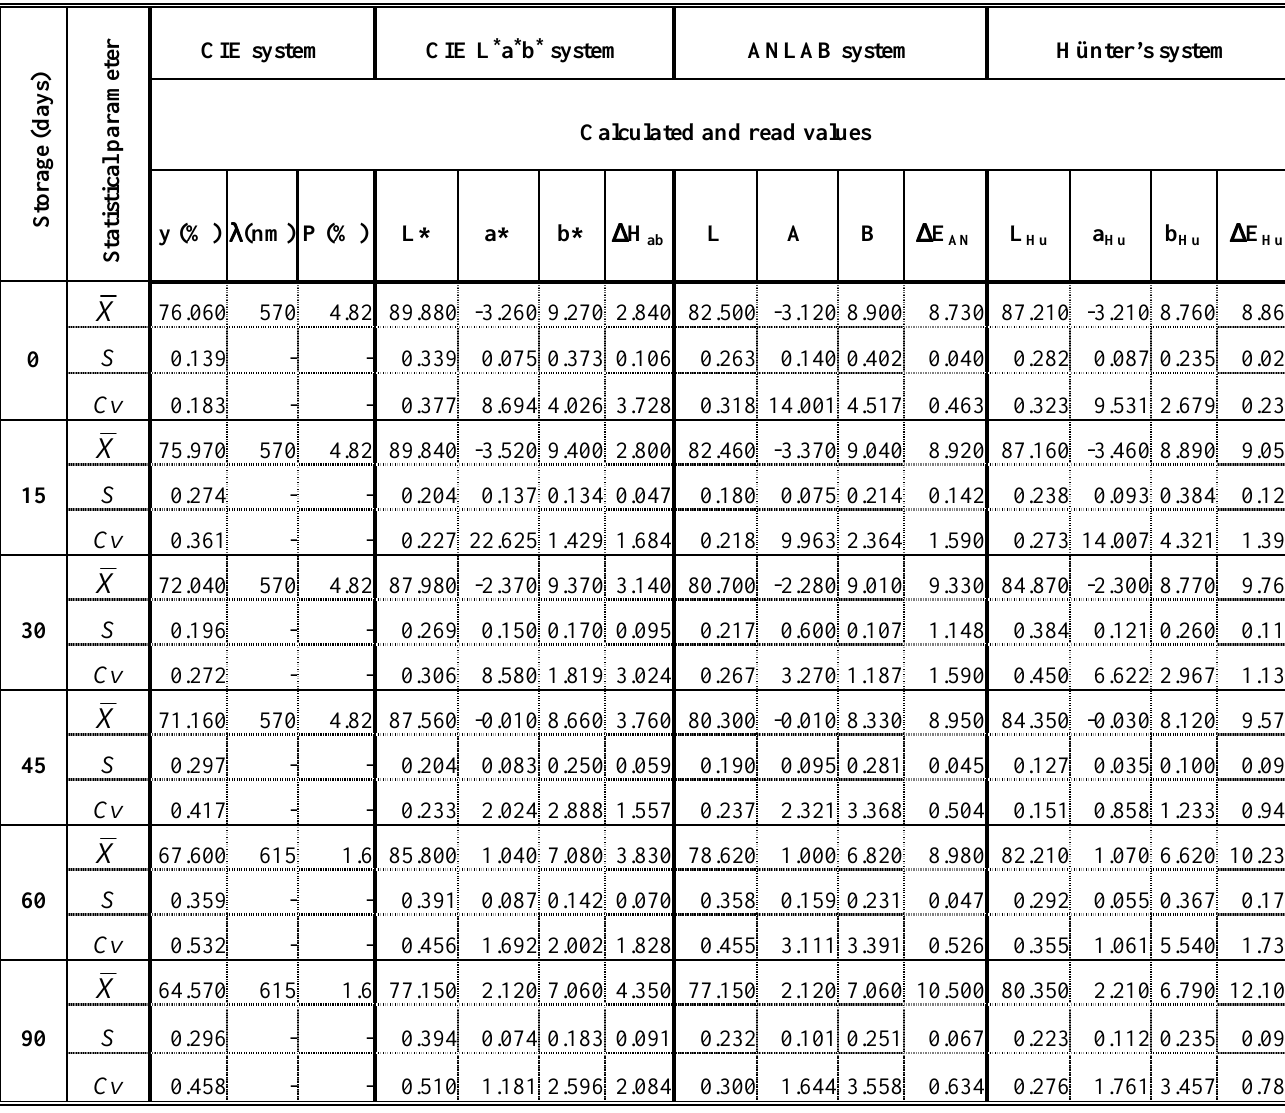
Table 1. Results of instrumental determination of color of UHT milk with 3.2% milk fat during storage up to 90 days at ambient temperature (20 ±